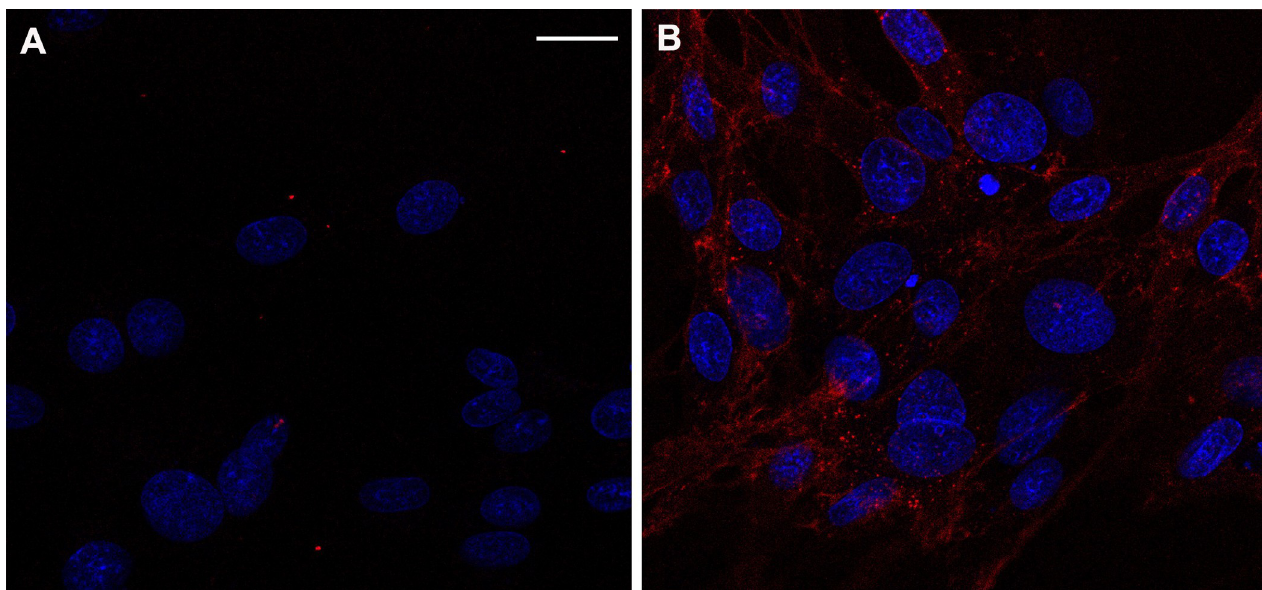
Fig 3. TAT-NMR-CaM cell-penetration assay. A, control with 400 nM CBS-MBP only and B, TAT-NMR-CaM/CBS-MBP (400 nM each) added to BHK cells; CBS-MBP was labelled (rendered as yellow) and cell nuclei (white) were stained prior to imaging with NucBlue. Cells were imaged with 40X objective at mid- point depth in cell and scale bar = 20 μ